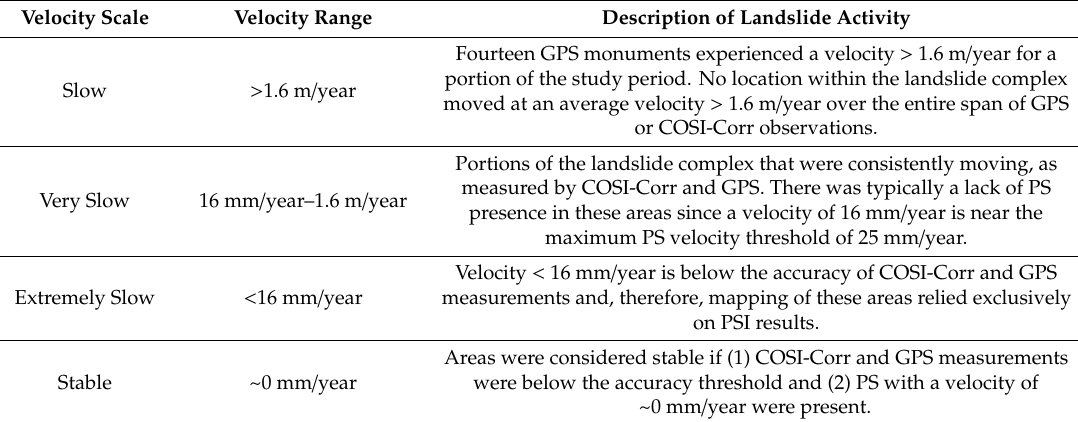
Figure 8. Activity within landslide complex based on Cruden and Varnes [29] landslide velocity scale. The slow landslide area (velocity > 1.6 m/year) is shown in red, the very slow landslide area (velocity between 16 mm/year and 1.6 m/year) is shown in yellow, and the extremely slow landslide area (velocity < 16 mm/year) is shown in green. Stable areas are those not colored with the new landslide activity red-yellow-green color scheme. Table 5. Landslide activity descriptions based on velocity scale at the Portuguese Bend landslide complex.